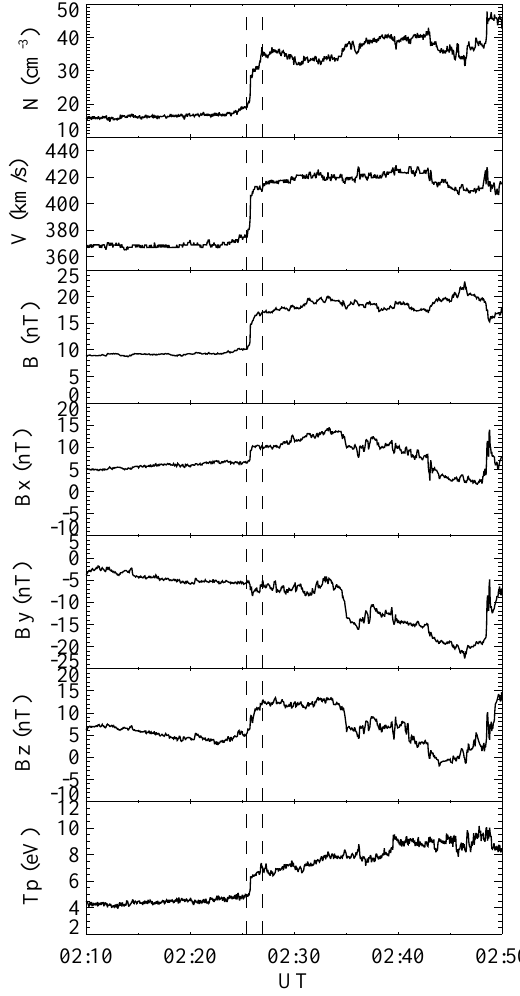
Fig. 5. Solar wind conditions in the GSE coordinate system for the 4 November 2000 event. The parameters are shown in the same format as in Fig.